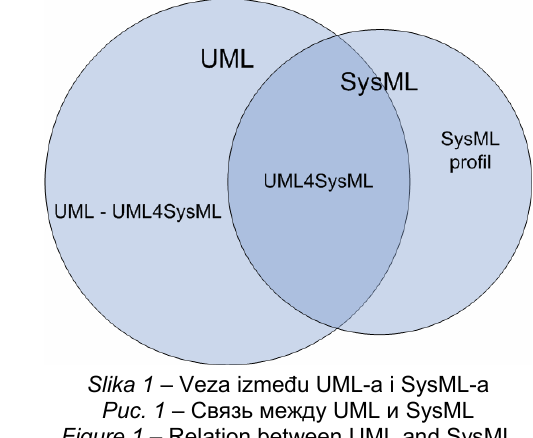
Рис . 1 – Связь между UML и SysML Figure 1 – Relation between UML and